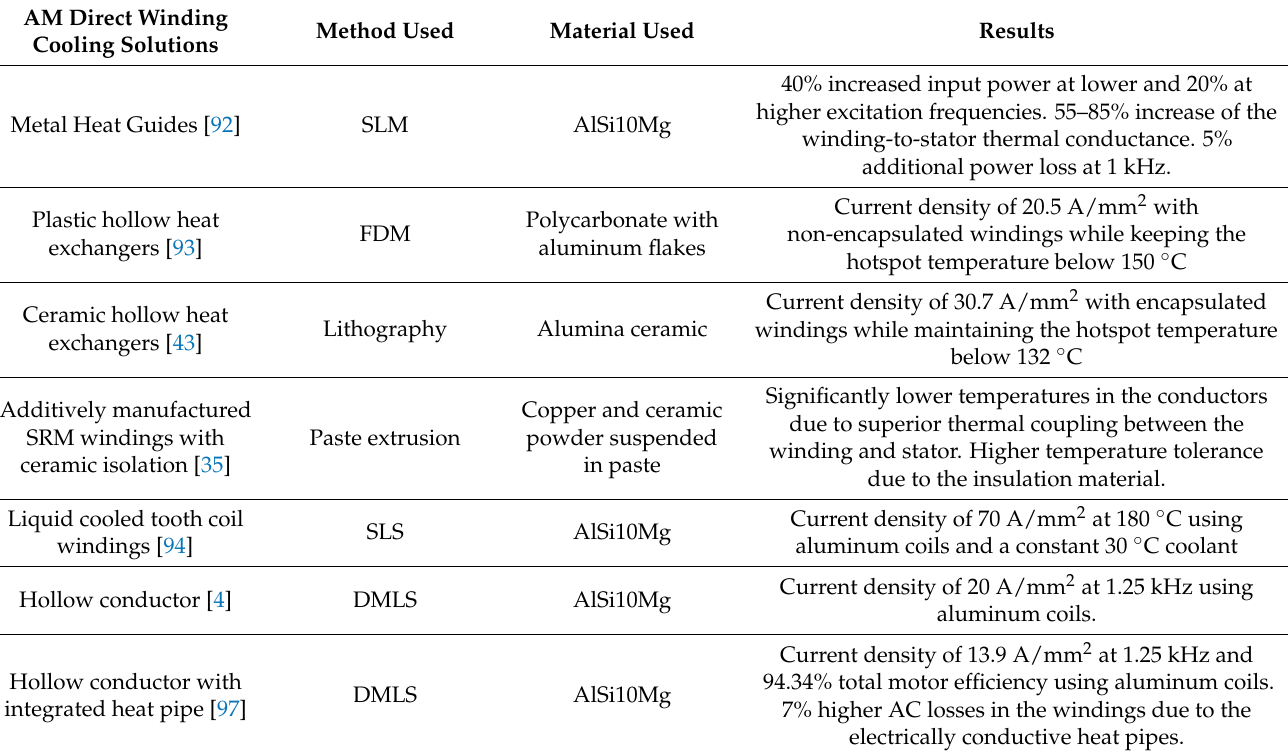
Table 2. Comparison of different AM direct conductor cooling solutions.